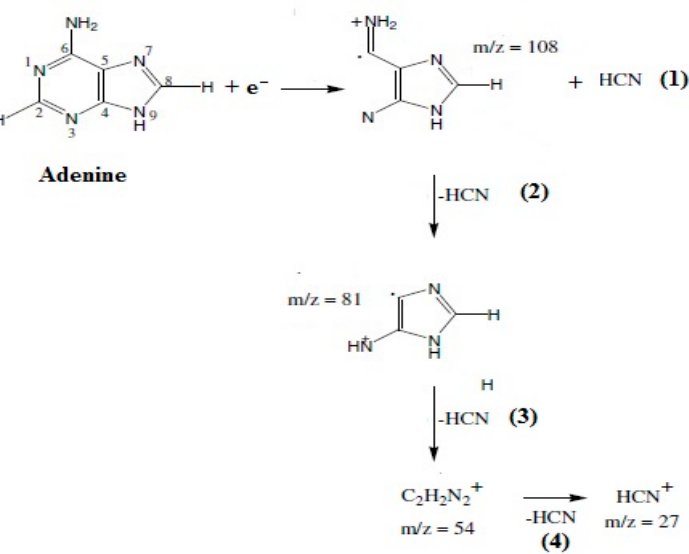
Figure 2. Principal pathway involved in fragmentation of adenine on ionization.